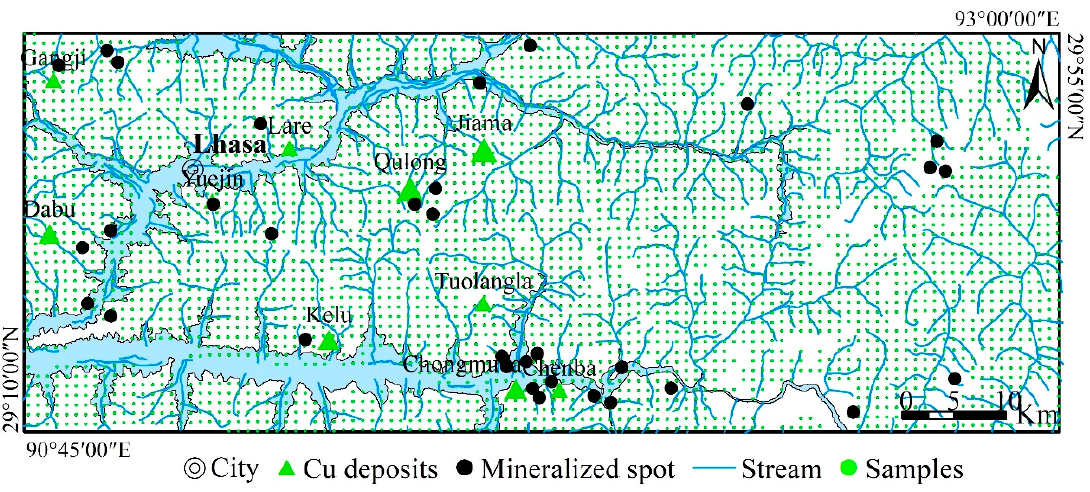
Figure 7. Geochemical sampling locations.